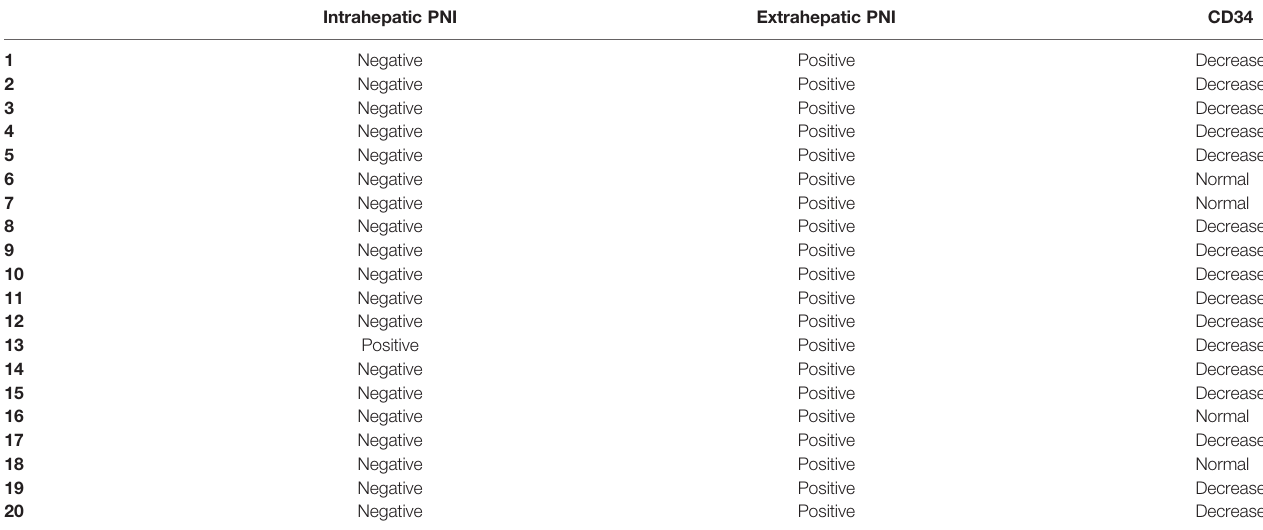
TABLE 2 | Characteristics of